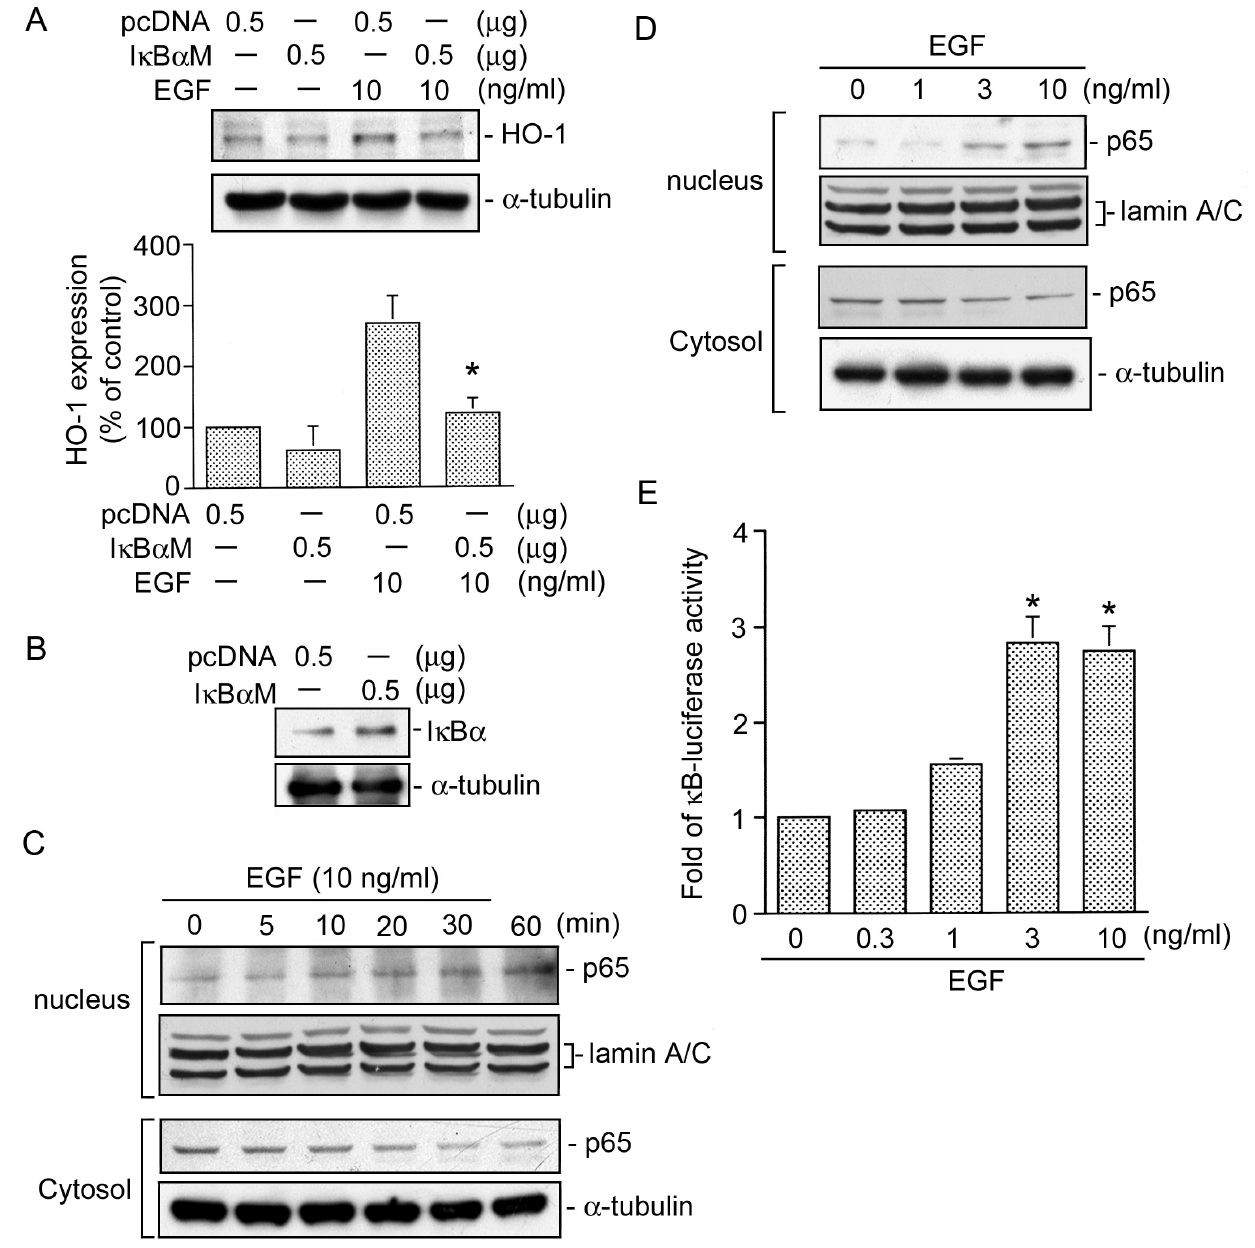
Figure 7. Nuclear factor (NF)- k B is involved in epidermal growth factor (EGF)-induced heme oxygenase (HO)-1 expression in HT-29 cells. A, HT-29 cells were transfected with 0.5 m g pcDNA or 0.5 m g I k B a M for 24 h, and then stimulated with 10 ng/ml EGF for another 18 h. After incubation, HO-1 and a -tubulin protein levels were determined. Immunoblots are representative of three experiments, which are presented as the mean 6 SEM. *p , 0.05, compared to EGF treatment. B, Cells were transiently transfected with either 0.5 m g of pcDNA or 0.5 m g of I k B a M for 24 h. Levels of I k B a and a -tubulin protein expression were determined by a Western blot analysis. Traces represent results from three independent experiments. HT-29 cells were treated with 10 ng/ml EGF for the indicated time intervals (C) or treated with EGF (1 , 10 ng/ml) for 20 min (D). The cytosolic and nuclear fractions were then isolated, and the protein levels of p65 in the cytosolic and nuclear fractions were determined by Western blot analysis. Typical traces represent three experiments with similar results. Lamin A/C and a -tubulin were respectively used as nuclear and cytosolic internal controls. E, HT-29 cells were transiently transfected with 0.5 m g of pGL2-ELAM-Luc and 0.5 m g of pBK-CMV-Lac Z for 24 h. Cells were then stimulated with HT-29 (0.3 , 10 ng/ml) for another 24 h. Luciferase activities were determined as described in ‘‘Materials and Methods’’. The level of induction of luciferase activity was compared to that of cells without EGF treatment. Data are presented as the mean 6 SEM. of three experiments performed in duplicate. * p , 0.05, compared to the control without EGF treatment. that c-Src is a downstream molecule of the EGFR, and we raised including cell survival, proliferation, migration, cancer formation, the question of whether c-Src plays an important role in EGF- and inflammatory gene expression [46]. A previous report showed induced HO-1 expression. In human conjunctival goblet cells,